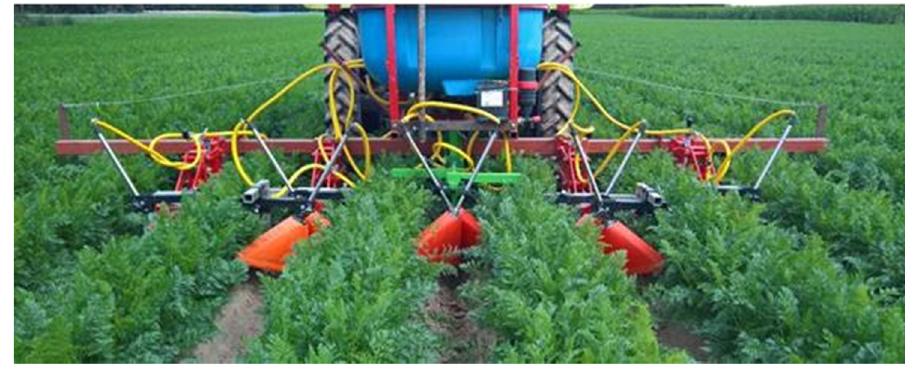
Figure 3: Precise spraying of carrots on ridges in BBCH 45 phase ( photo: Przygodzi ń ski 2018 )